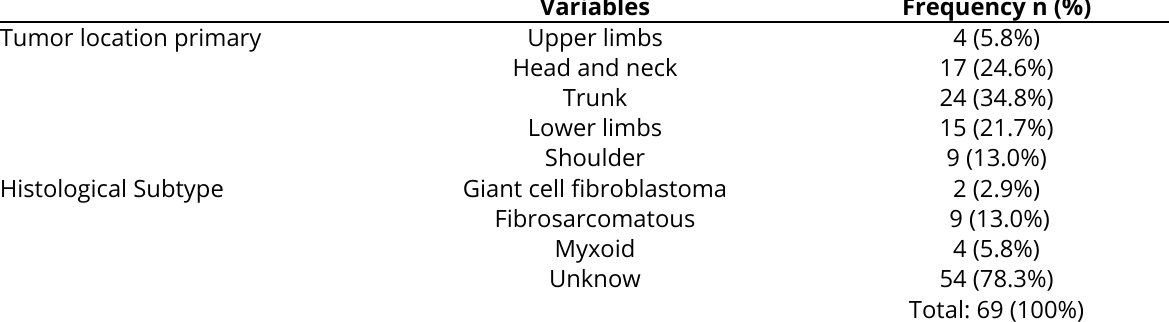
Table 2 – Clinical characteristics of patients with Dermatofibrosarcoma at Barretos Cancer Hospital.